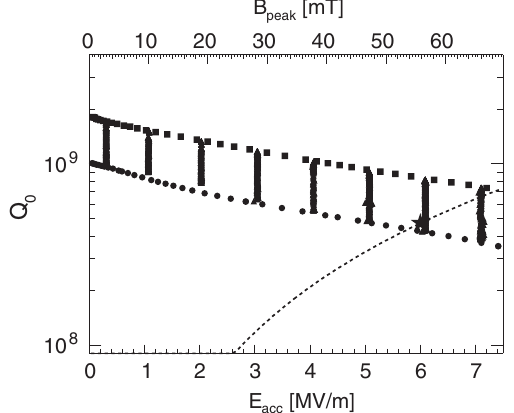
FIG. 3. Quality factor as a function of accelerating gradient for an enhanced external magnetic field ( 100 μ T). The circle points show 4.5 K and square ones show 2.4 K. The triangle points are data of intermediate temperature at fixed fields. The dashed line shows 10 W power consumption and the star is the nominal